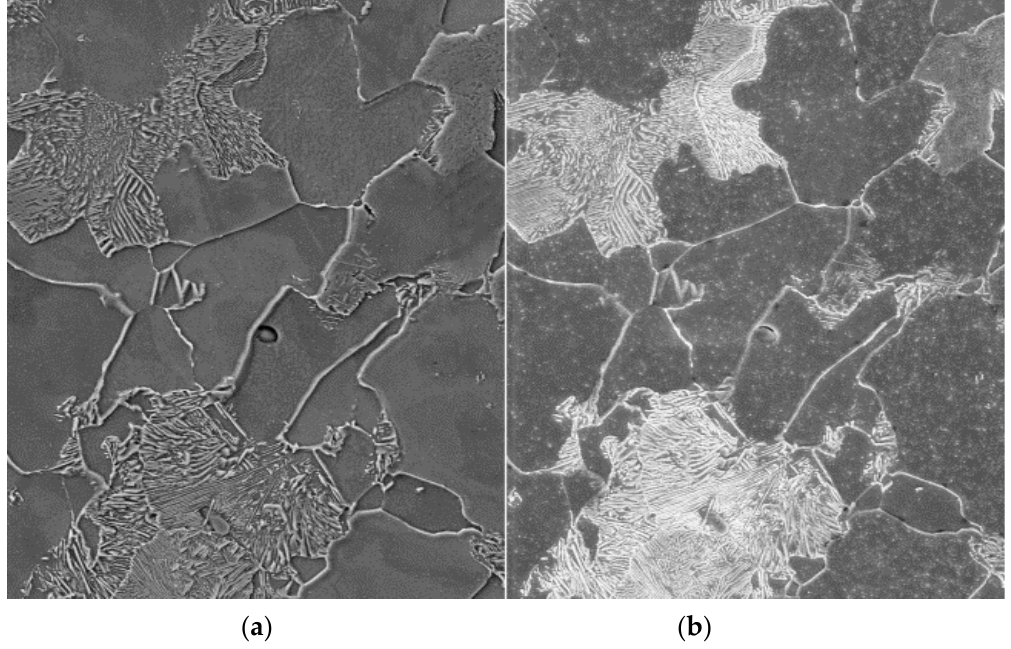
Figure A4. Example of a microstructure surface using different modules: ( a ) SE, ( b ) “InLens”. Different contrast values were used in the settings of the electron beam microscope (Figure A5a contrast = 49%, Figure A5b contrast = 52%).